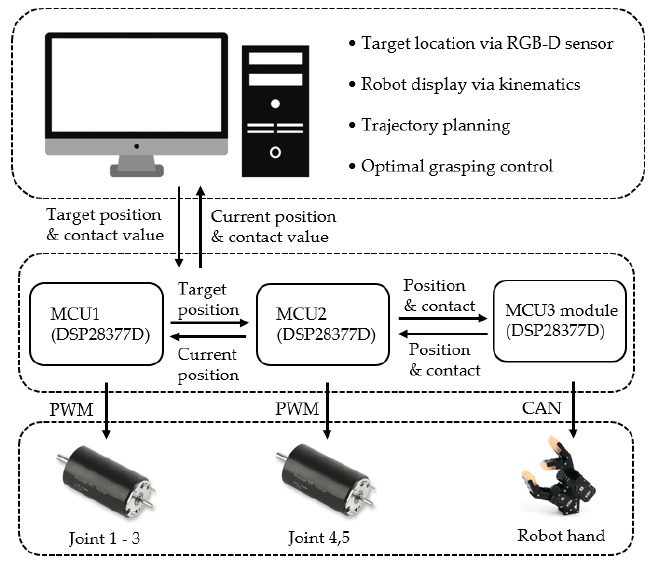
Figure 19. Control system configuration.